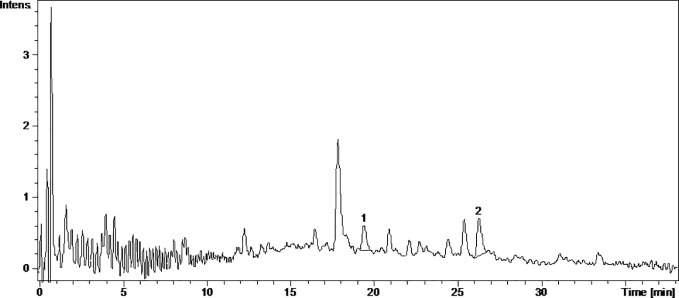
The UV chromatogram of frtmented Pinot noir 2015 grape pomace extract. 1, Isoquercitrin; 2, Quercetin.